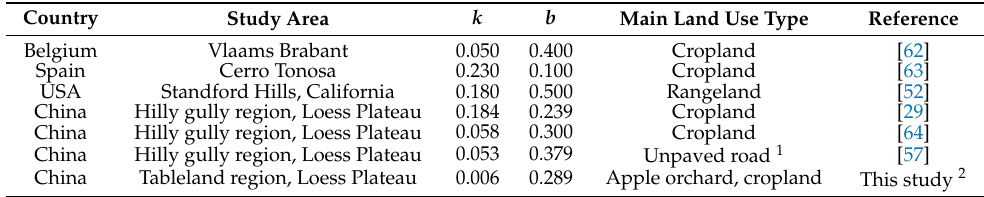
Tableland region, Loess Plateau